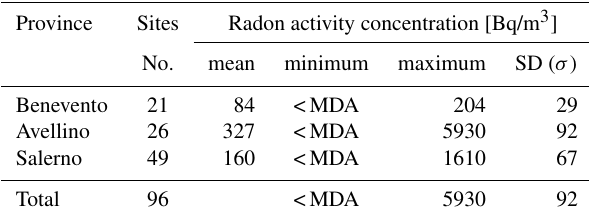
Table 2. Measured values of radon activity concentrations in indoor